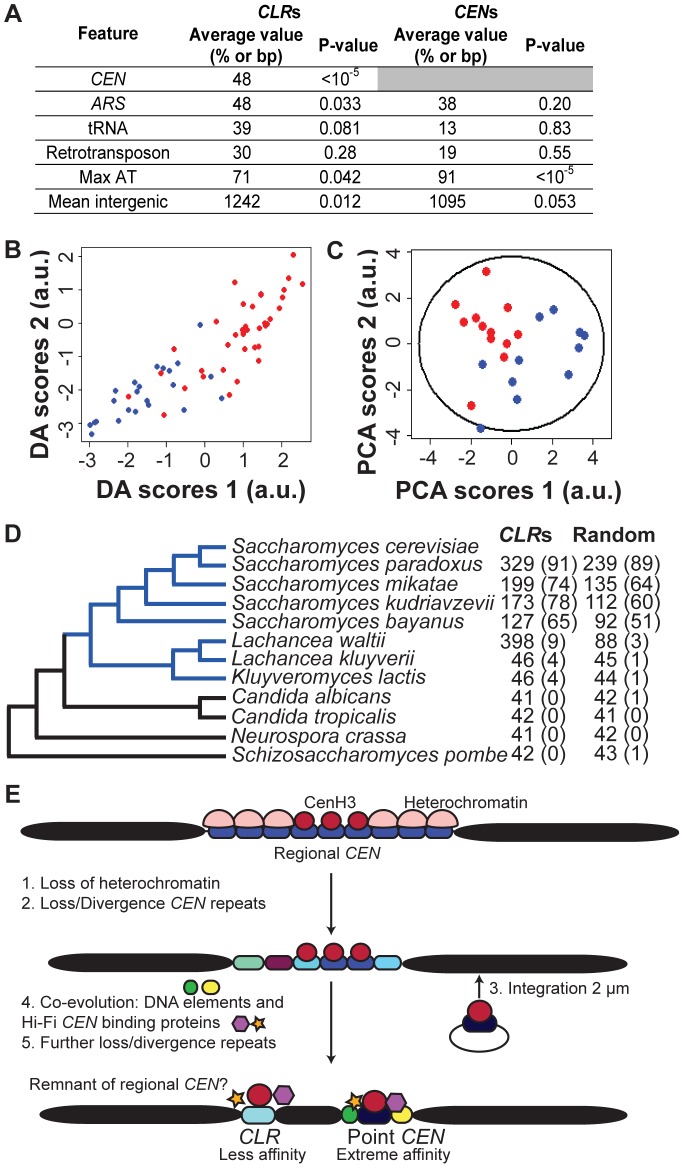
Genomic features of CLRs.(A) Comparison of CLRs and CENs. Average value refers to the fraction of CLRs or CENs located within 25 kb of a CEN or within 5 kb of an ARS, tRNA or retrotransposon. Mean intergenic indicates the average length of intergenic regions. Max AT represents the mean AT content of the most AT-rich 90-bp stretch of DNA. (B) CLRs can be separated from other genomic regions, using Discriminant Analysis (DA). Scores of CLRs (blue) and negative control regions (red) are plotted according to their discriminant function scores (Table 2). (C) Centromere proximity is a major contributor to variability among CLRs, as revealed by Principal Component Analysis (PCA). Scores of CEN-proximal (<25 kb, blue) and CEN-distal (>25 kb, red) CLRs are plotted relative to the first and second principal components (Table 3), along with a 95% confidence ellipse. (D) Conservation of CLR sequences among organisms with point CENs (blue), but not with fungi bearing regional CENs (black). Nucleotide blast (Blastn) was performed for 23 CLRs and 160 random intergenic regions. Mean BLAST scores are reported, with the percent of hits with a score over 45 (E<0.05) in parentheses. (E) Given our data and the confinement of CLR sequences to budding yeast bearing point centromeres, we proposed a modified version of the current model of centromere evolution (originally postulated in [1]), from regional to point CENs, to account for CLRs. CLRs would represent evolutionary remnants from regional CENs. Some AT-rich CEN repeats would have diverged but still retained the ability to bind Cse4 and other kinetochore proteins weakly, giving rise to the low-affinity CLRs observed in this study.